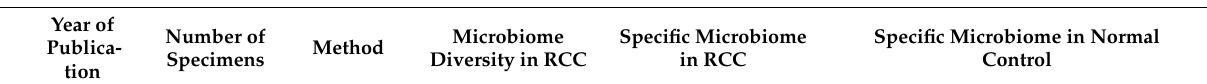
Table 1. Cont. Different Microbiome in Normal and RCC